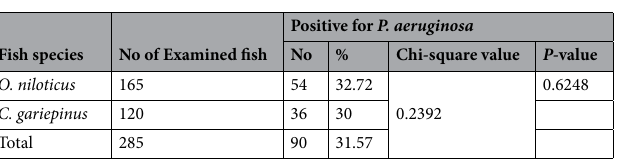
Table 2. Total prevalence of P. aeruginosa among the examined O. niloticus and C. gariepinus .